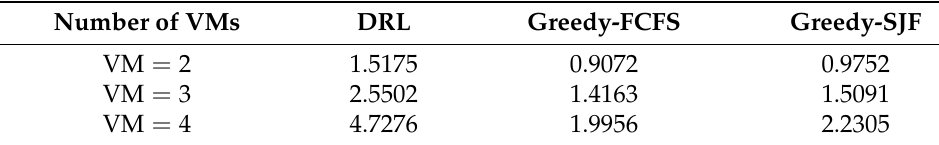
Table 3. Comparison of the average task satisfaction degree.